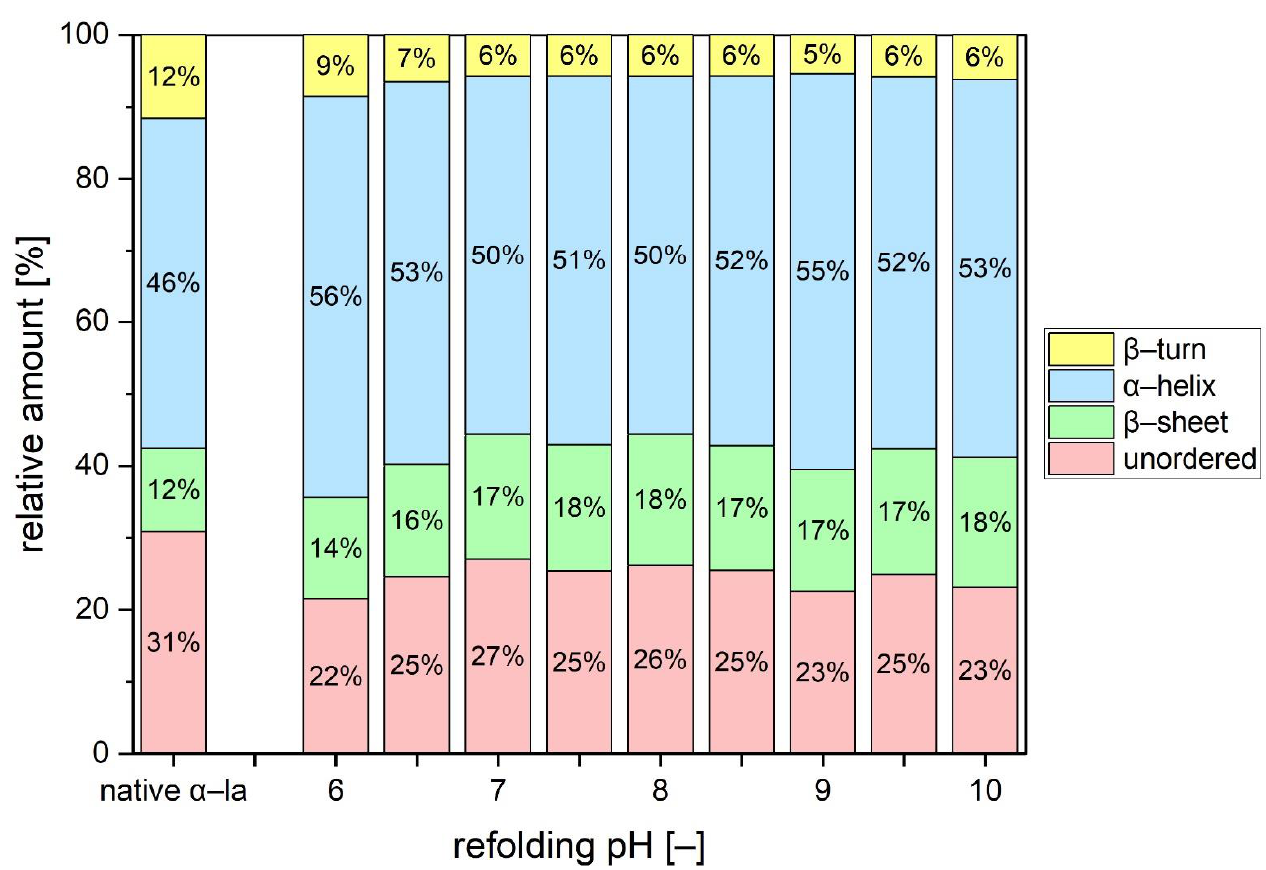
Figure 5. The relative amounts of secondary structural motives calculated based on FTIR curve areas displayed for the refolded batches and the native α -la sample. Data are given as mean, n = 2. All refolded batches were significantly different from native α -la ( p < 0.05).